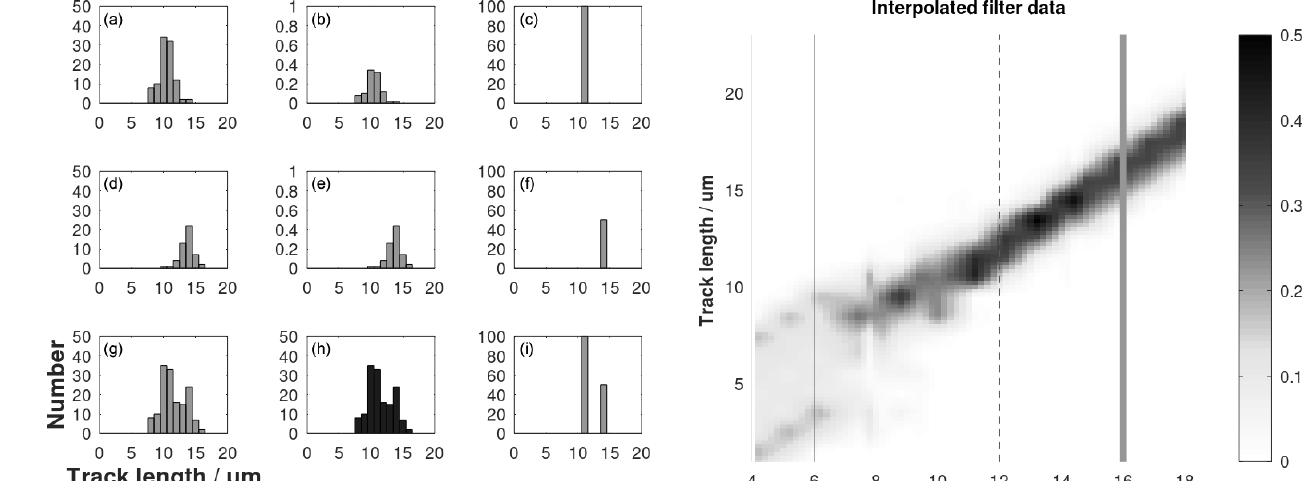
Figure B1. Interpolation of the filters used for deconvolution. It is based on track annealing in the laboratory (Gleadow et al., 1986a; Green et al., 1986; Barbarand et al., 2003). Three linear intersec- tions are shown in Fig. B2. The greyscale range denotes frequency.